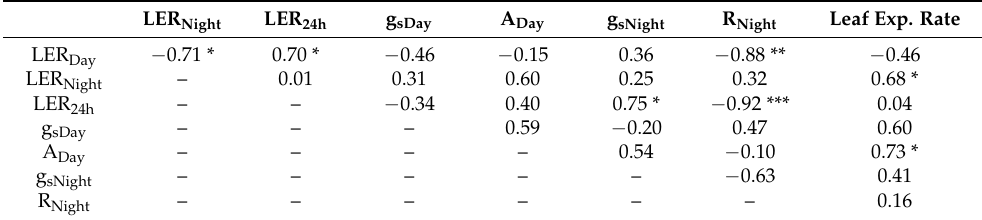
Table 9. Pearson regression coefficients for the correlations between leaf elongation rates (LER) during day, night and 24 h, stomatal conductance (g s ) during day and night, assimilation rate (A) and respiration rate (R) and leaf area expansion rate of plants grown under different day and night temperature and RH regimes. ***, **, *: significant at p < 0.001, p < 0.01, p < 0.05, respectively. LER Night LER 24h g sDay A Day g sNight R Night Leaf Exp. Rate LER Day − 0.71 * 0.70 * − 0.46 − 0.15 0.36 − 0.88 ** − 0.46 LER Night – 0.01 0.31 0.60 – – − 0.34 0.40 0.75 * − 0.92 *** 0.04 g sDay – 0.59 − 0.20 0.47 0.60 A Day 0.54 − 0.10 −